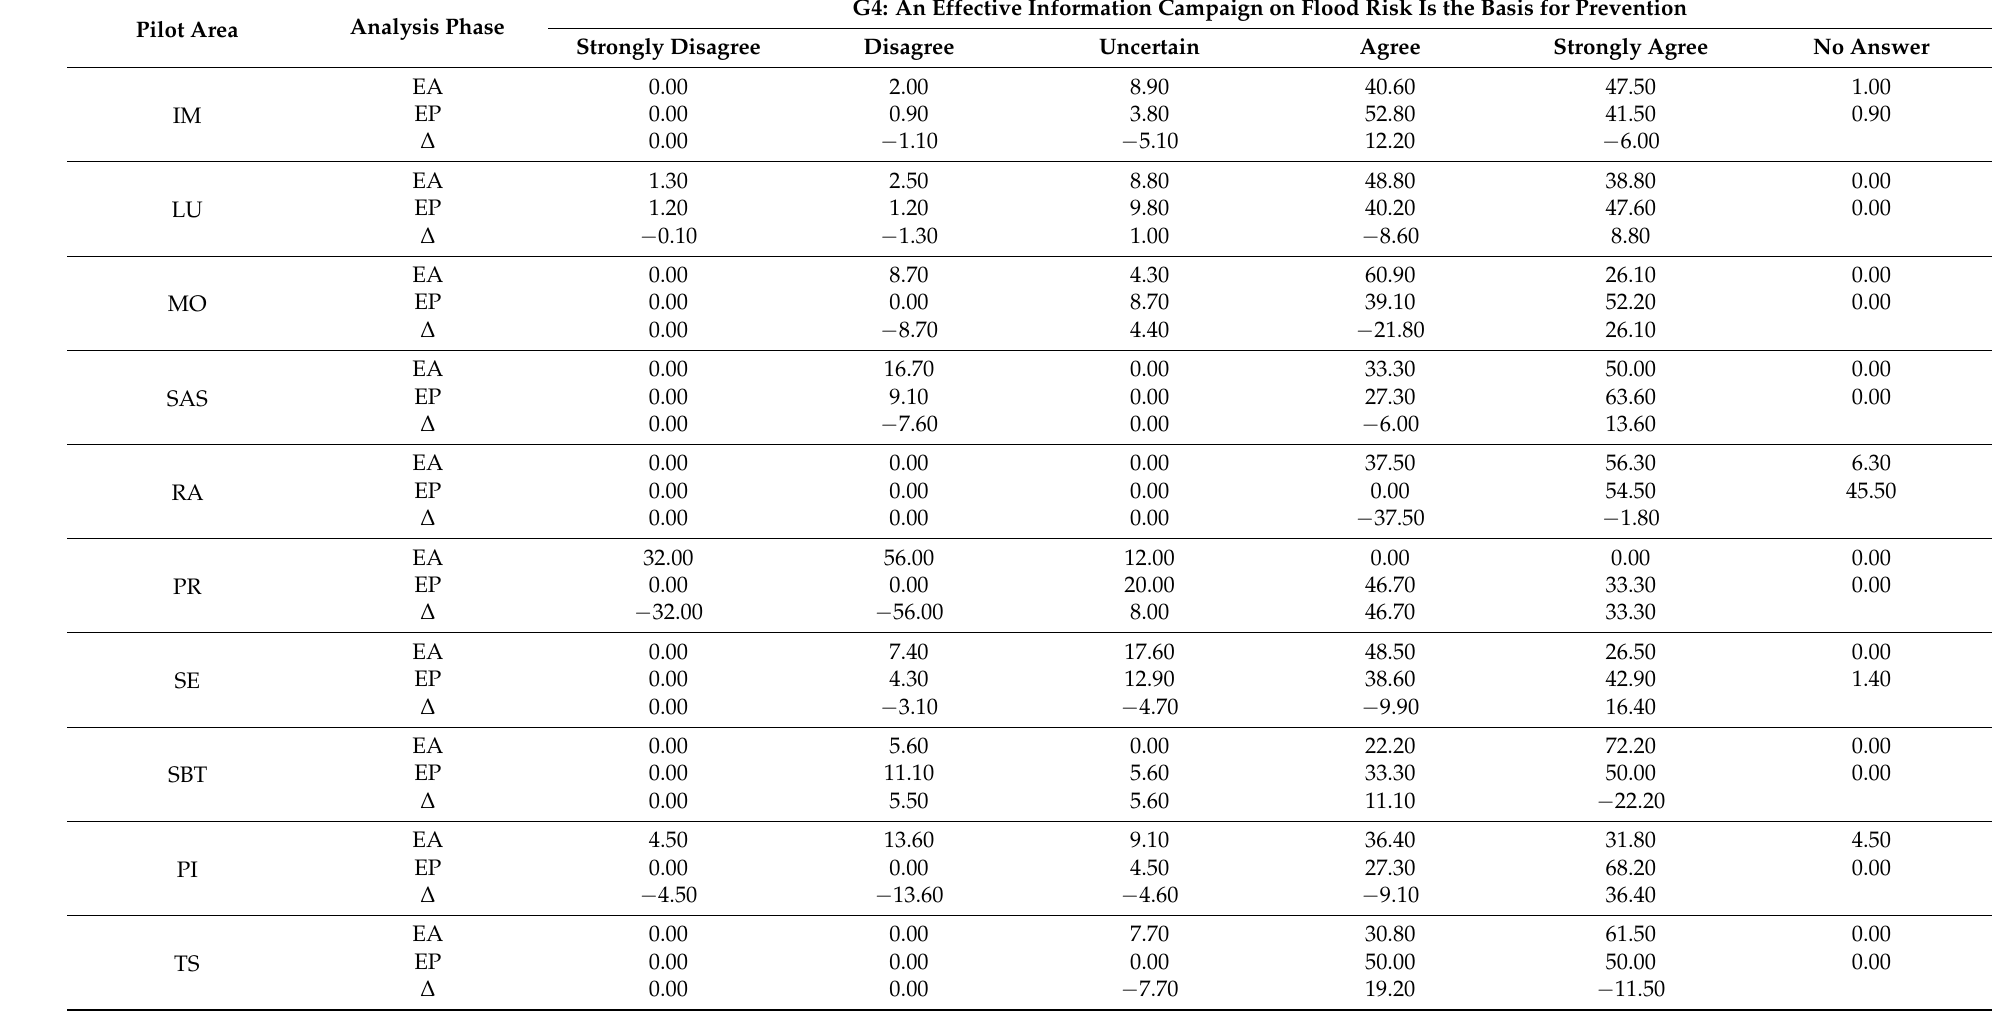
Table A5. Answers to the question G4 in percentages per each pilot area, in the ex-ante (EA) and in the ex-post (EP) phases, and their variation ( ∆